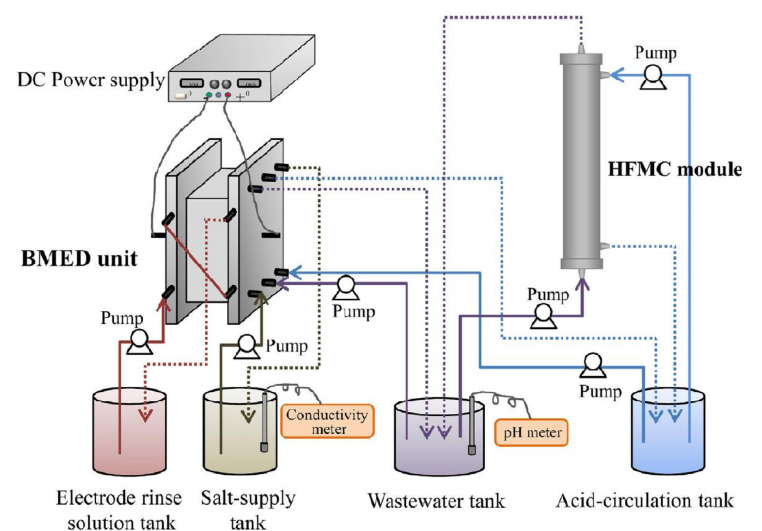
Figure 7. Schematic experimental setup of bipolar membrane electrodialysis and hollow fiber membrane contactor for ammonia capture from wastewater